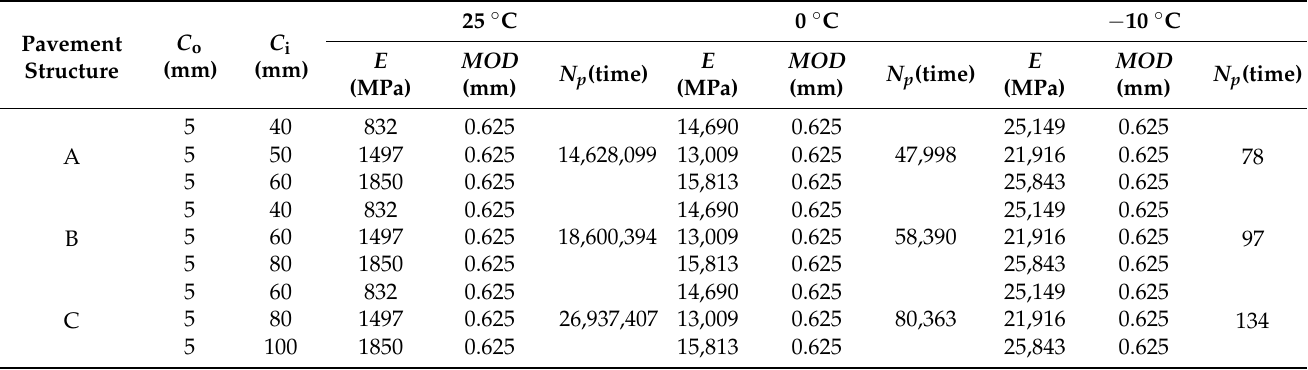
Table 10. Crack propagation life for each structure of asphalt